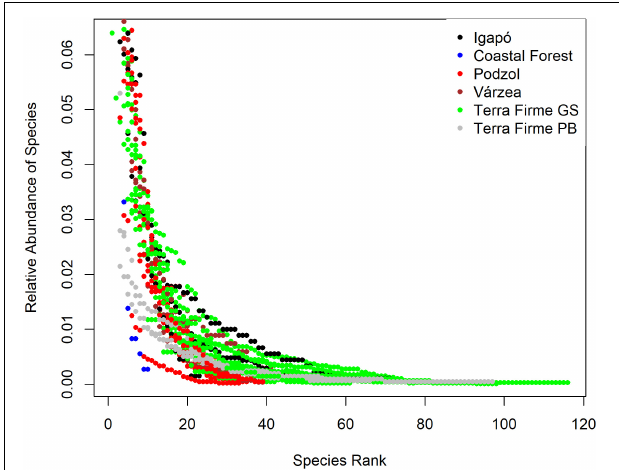
FIGURE 4 | Abundance ranking of vascular epiphyte species for the different environments in the Amazon basin.